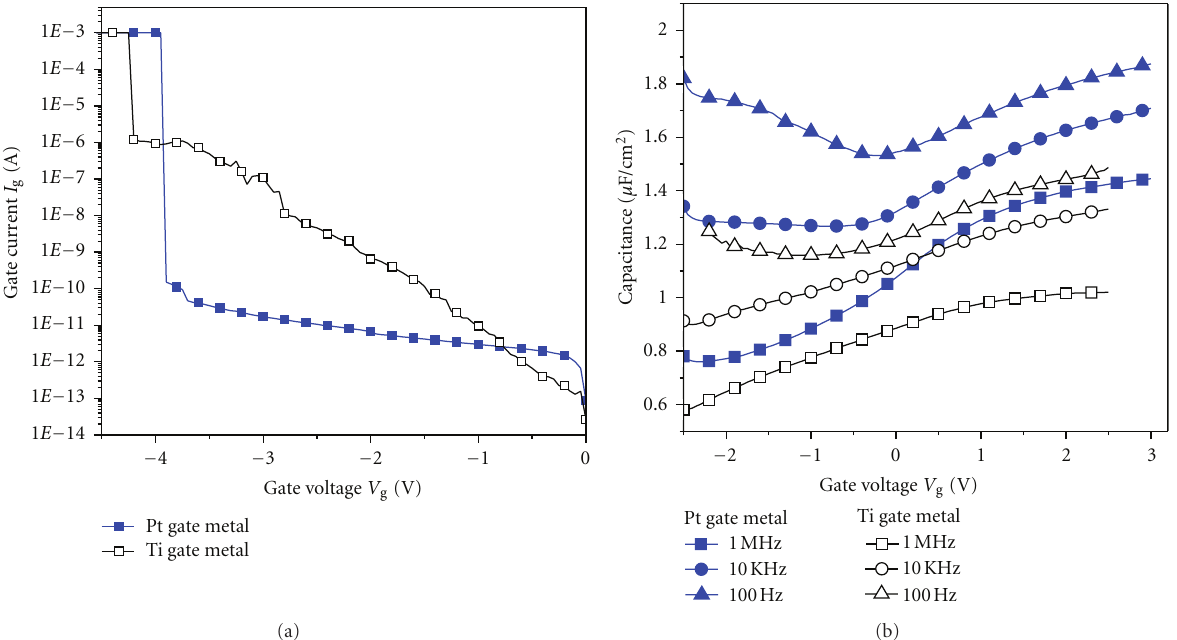
Figure 3: (a) I - V and (b) C - V characteristics of HfO 2 /InP/InAs MOS capacitors of 100 × 100 µ m 2 with Ti and Pt gate metal, respectively.